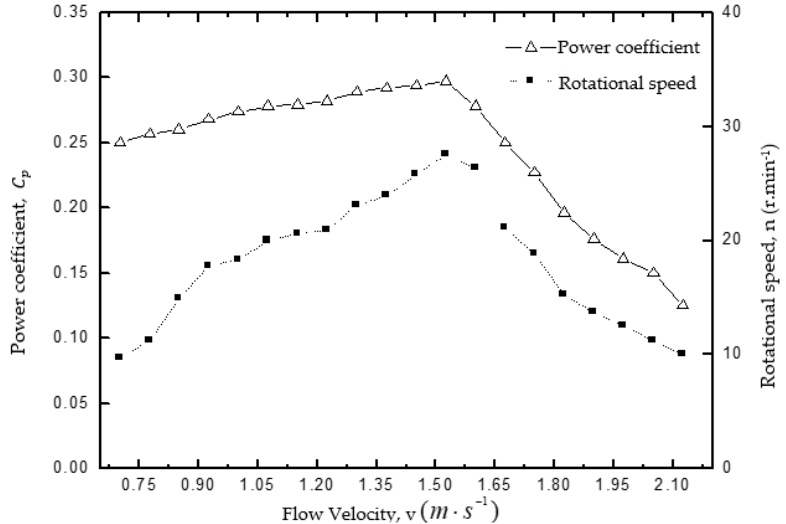
Figure 10. Performance of the blade under different velocities.